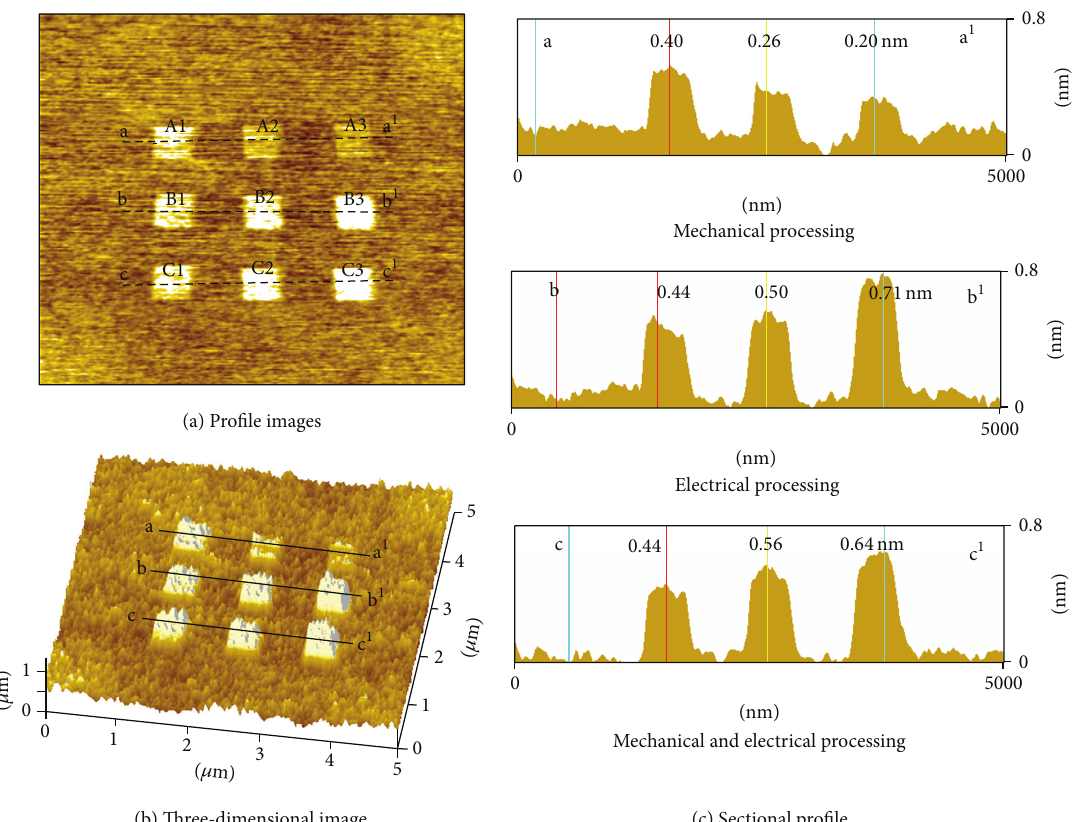
Figure 20: AFM profiles and cross-sectional images of surfaces obtained by (a) mechanical, (b) electrical, and (c) electromechanical